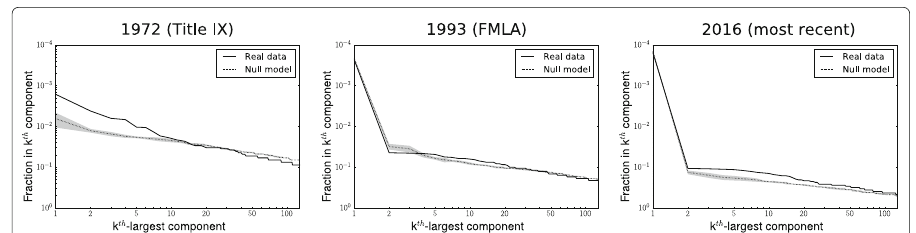
year. Solid black curve denotes the INFORMS network, and the shading denotes the range ( ± 1 standard deviation) of a typical run of the null model (with parameters D = 4 and n nei = 1) about the mean of 8 instances of the null model (dotted